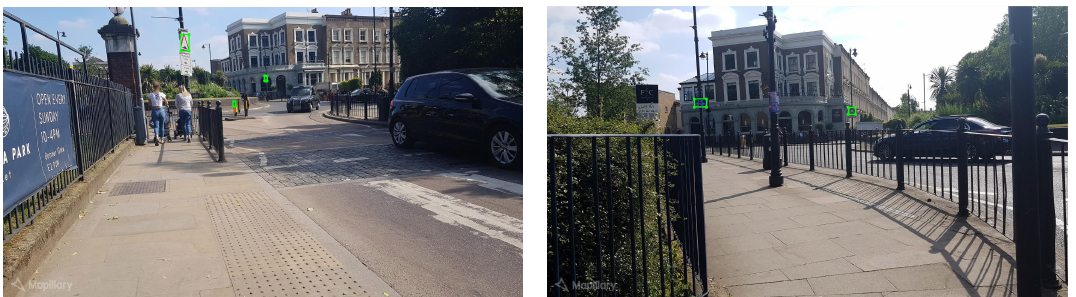
Figure 6. Consecutive frames of two example scenes of the Mapillary dataset.